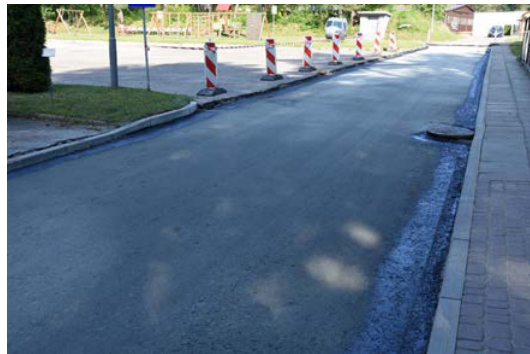
Figure 7. Unbound aggregate base course ready for laying the binder course made of AC 16W.